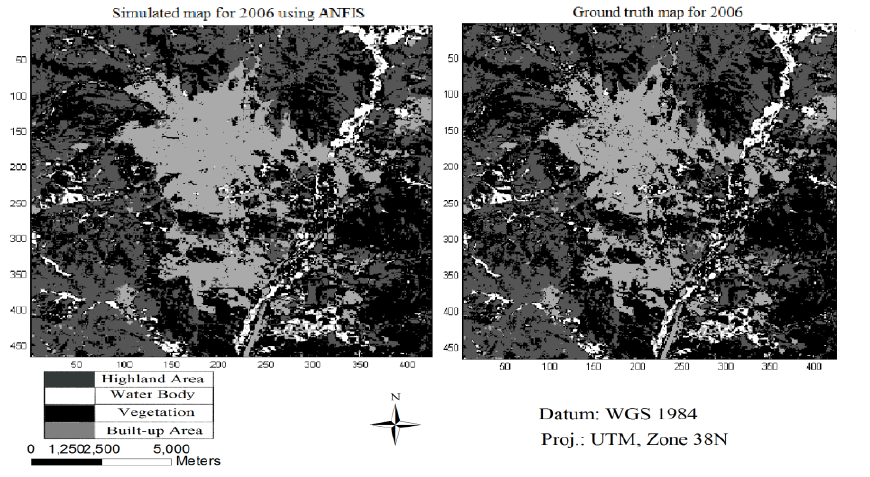
Figure 3 Simulated map compare with ground truth map for